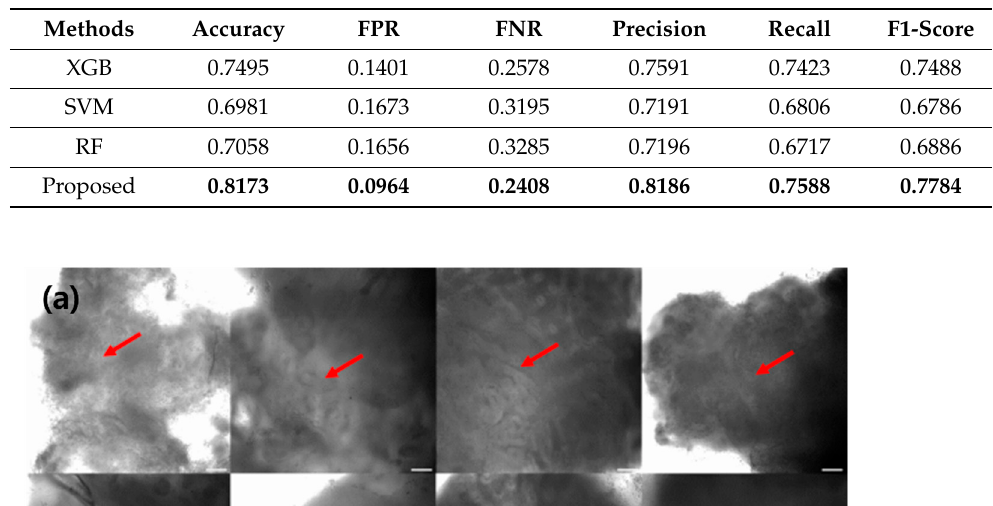
Table 4. Machine learning and deep learning performances.